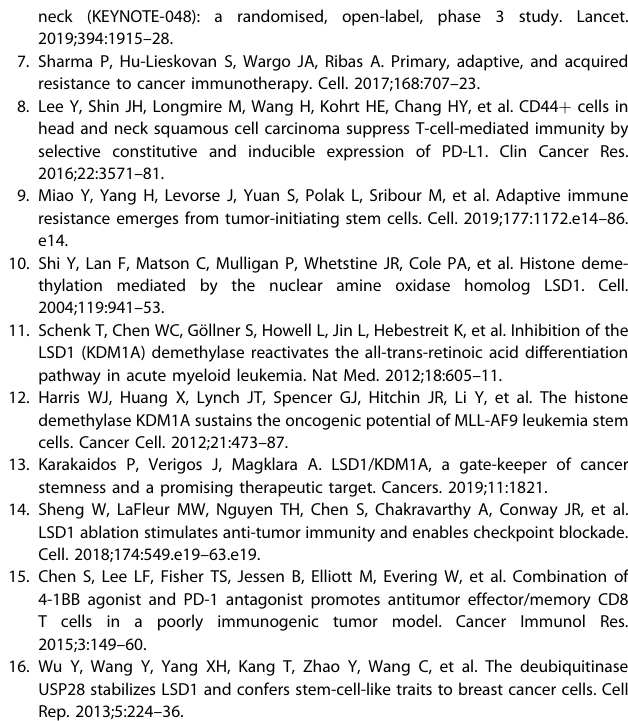
Fig. 8 A proposed model showing a novel therapeutic strategy for HNSCC patients by using a combination of LSD1 inhibition and PD-1 blockade. High expression of LSD1 promotes the CSC properties by regulating Bmi-1 expression. Inhibition of LSD1 induces the upregulation of PDL1 levels and promotes tumor immune evasion. Combination of LSD1 inhibitor and anti-PD-1 monoclonal antibody can overcome tumor immune evasion and greatly inhibit tumor growth, which providing a novel and promising combined strategy for the treatment of